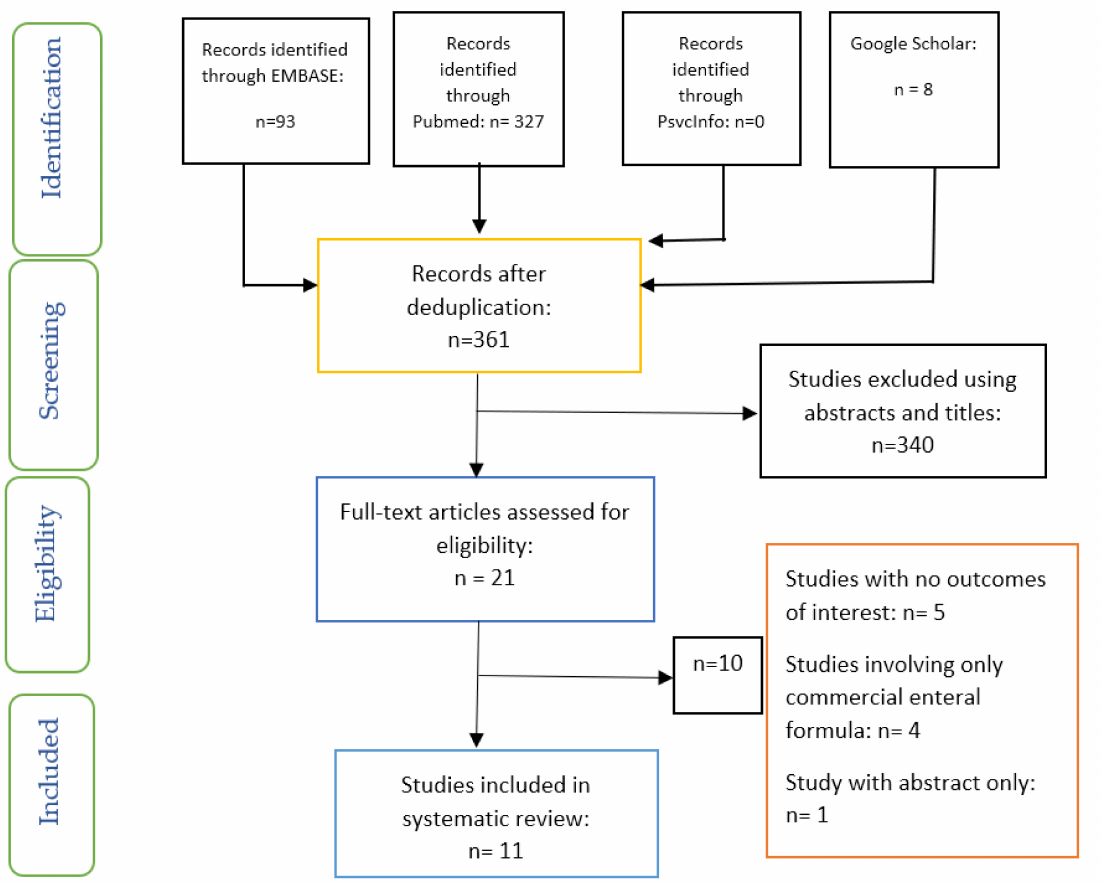
Figure 1. Preferred reporting items for systematic reviews and meta-analyses (PRISMA) flow chart on the selection and inclusion of